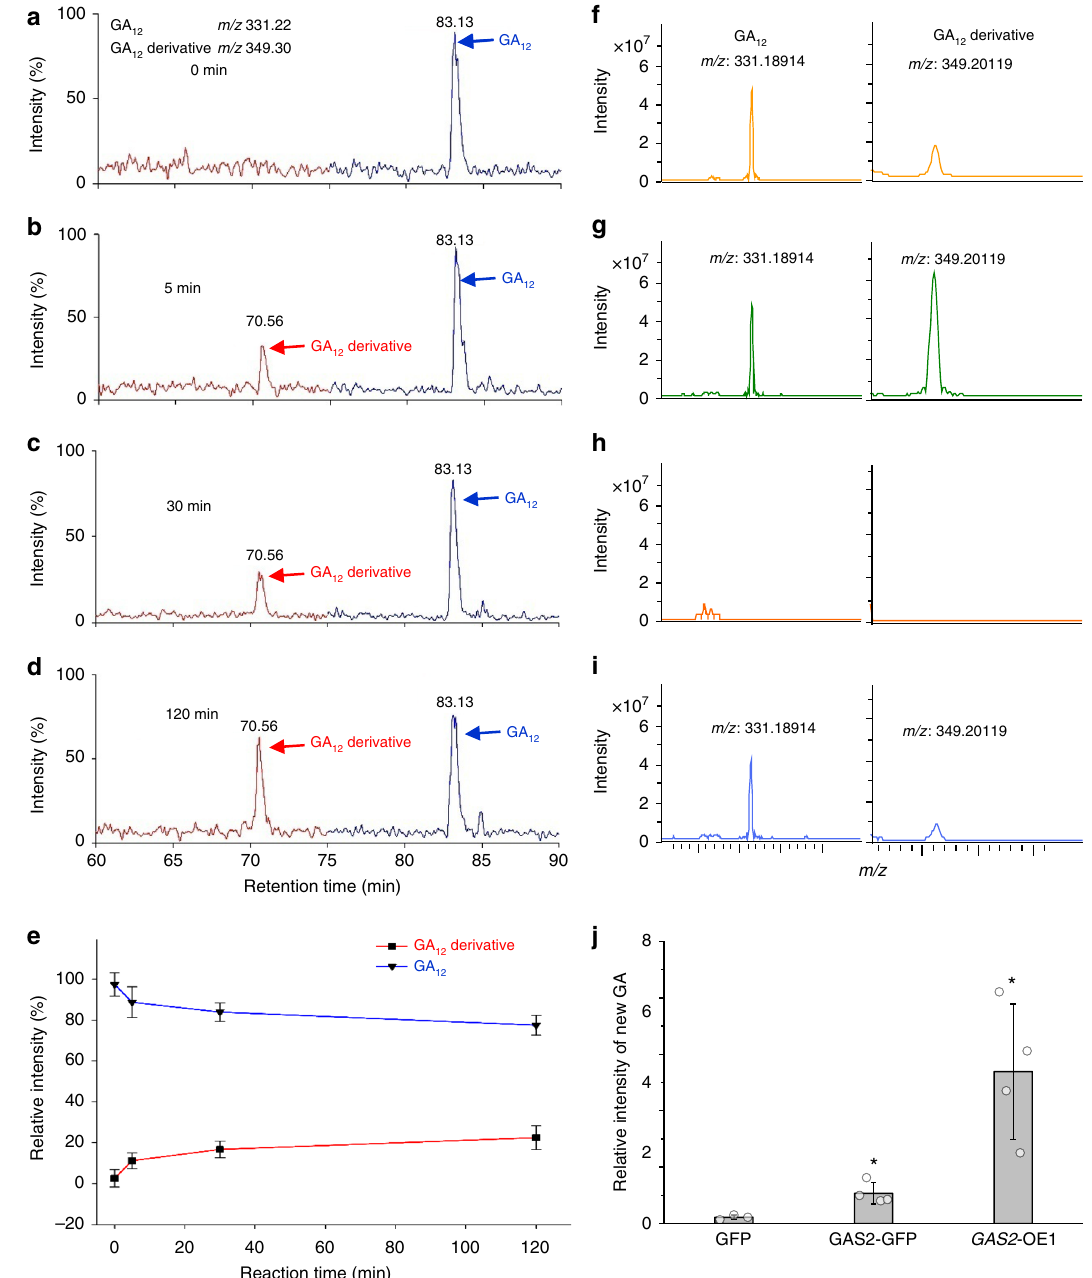
Fig. 3 Analysis of products produced by the catalytic conversion of GA 12 by GAS2 in vivo and in vitro. a – d LC-MS base peak chromatogram of the products generated by the catalytic conversion of GA 12 by GAS2 at different time intervals (0, 5, 30, and 120 min). [17,17- 2 H 2 ]-GA 12 was used in this assay. e LC-MS dynamic analysis of GA 12 and GA 12 derivative in the reaction solution at different time intervals (0, 5, 30, and 120 min). LC-MS liquid chromatography/ mass spectrometry. f – i GA 12 and GA 12 derivative detection using MALDI FTICR-MS spectra in 35S::GAS2-GFP (GAS2-GFP) ( f ), 35S::GFP ( i ) transiently transformed in protoplasts and GAS2- OE1 plants ( g ) with GA 12 (2.5 μ g/mL), 35S::GFP transiently transformed into protoplasts was used as a negative control without GA 12 treatment ( h ). j Relative intensity of GA 12 derivative in Arabidopsis protoplasts transiently transformed with 35S::GAS2-GFP (GAS2- GFP) and 35S::GFP (GFP) overnight. The protoplasts from GAS2 -OE1 plants (GAS2-OE1) were used as a control. GA 12 (2.5 μ g/mL) was supplemented as the substrate for GA 12 derivative synthesis catalyzed by GAS2. Values shown are means ± SD ( n = 3). * p < 0.05, t test. Source data are provided as